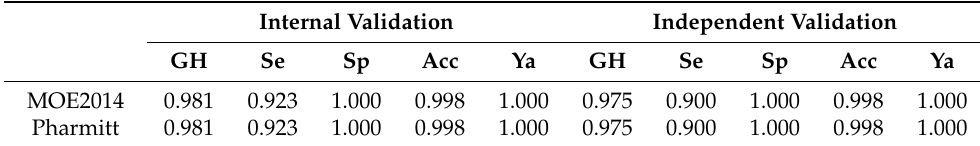
Table 1. The validation results for pharmacophore model 77.